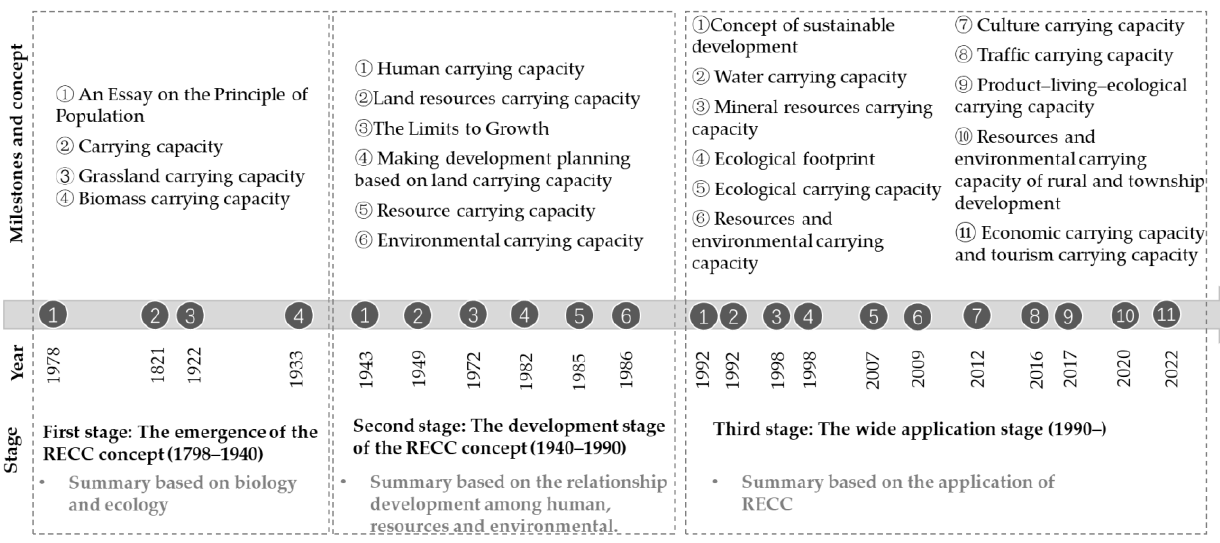
Figure 1. Milestones and concept of study on RECC. Table 1. Evolution of the RECC concept.